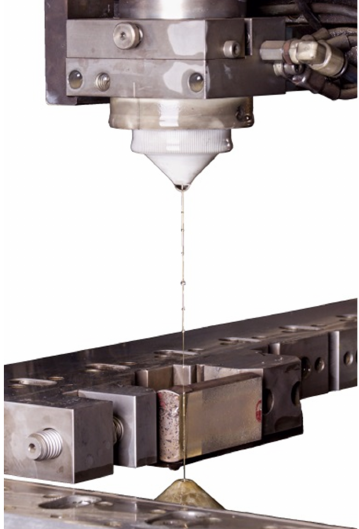
Figure 6. Method of clamping specimen 1 for wire EDM